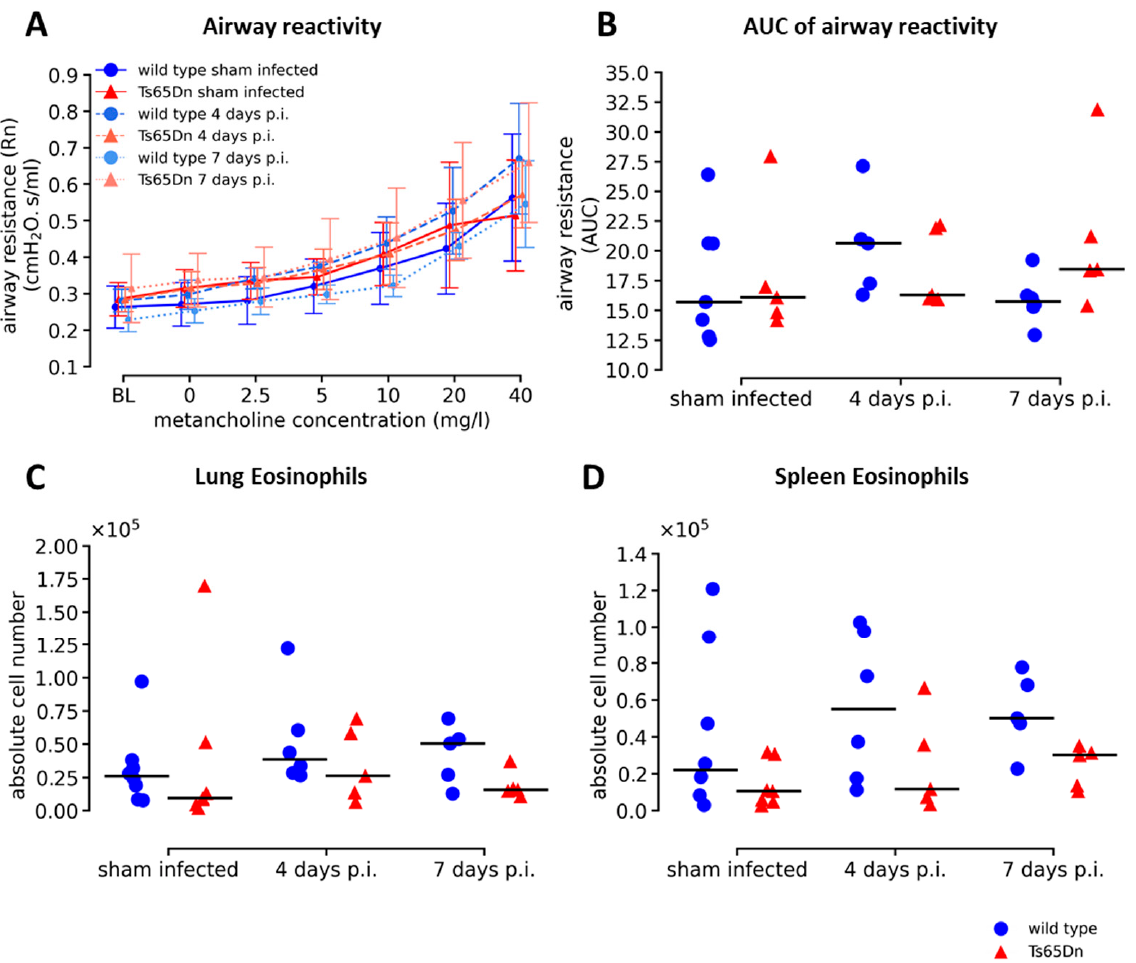
Figure 5. Airway responsiveness and asthmatic immune markers upon RSV infection. ( A ) Airway resistance was measured in response to increasing methacholine aerosol challenges (0–40 mg/mL) in wild type and Ts65Dn mice following sham, four days or seven days- rhRSV-Luc infection, and presented as group mean ± SD. The number of mice were: wild type sham infected (N = 8, 4days p.i. N = 4, 7days p.i. N = 4), Ts65Dn sham infected (N = 5, 4 days p.i. N = 2, 7 days p.i. N = 3), wild type infected (N = 10, 4 days p.i. N = 5, 7 days p.i. N = 5) and Ts65Dn infected (N = 9, 4 days p.i. N = 5, 7 days p.i. N = 4). ( B ) Calculations of the area under the curve (AUC) were presented for all groups and expressed as individual values with group median. The number of eosinophils in ( C ) lung and ( D ) spleen are measured using flow cytometry and presented as individual values, along with group median. Wild type (blue circle) and Ts65Dn (red triangle) with and without rhRSV-Luc infection were